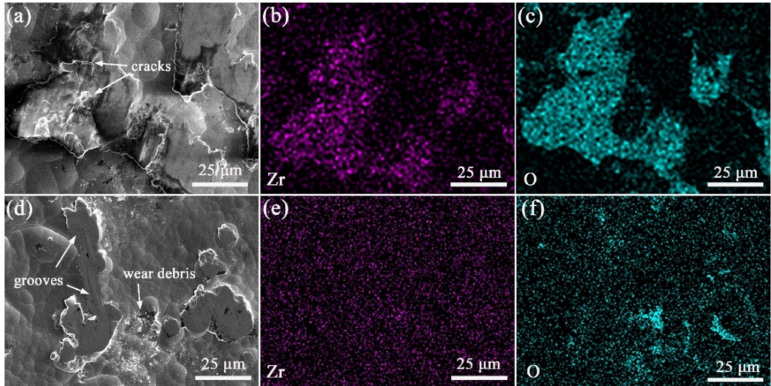
Figure 7. SEM images and EDS mapping of worn surface for ( a – c ) Ni-B alloy and ( d – f ) Ni-B-GO composite coating.